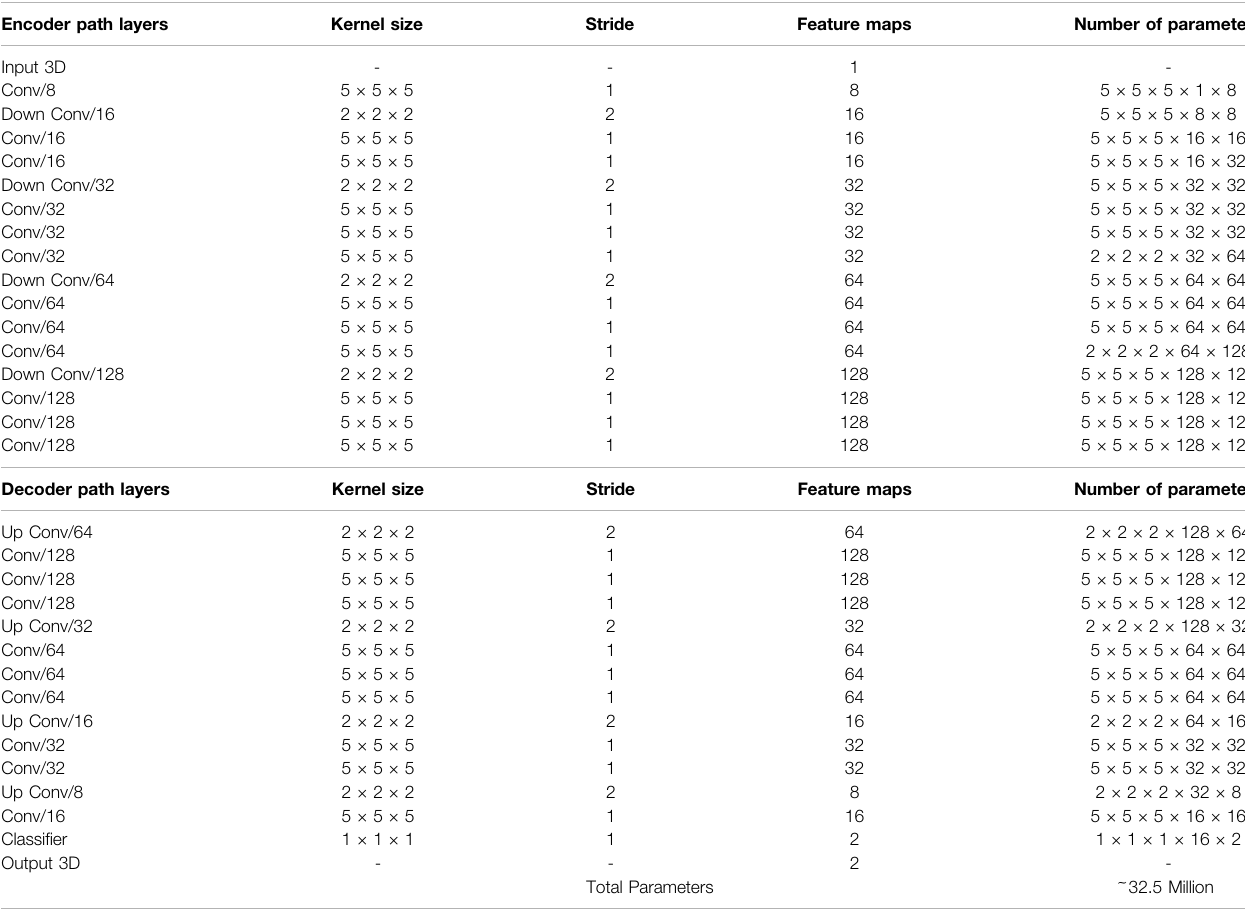
TABLE 1 | The con fi gurations of the convolutional neural network. Encoder path layers Kernel size Stride Feature maps Number of parameters